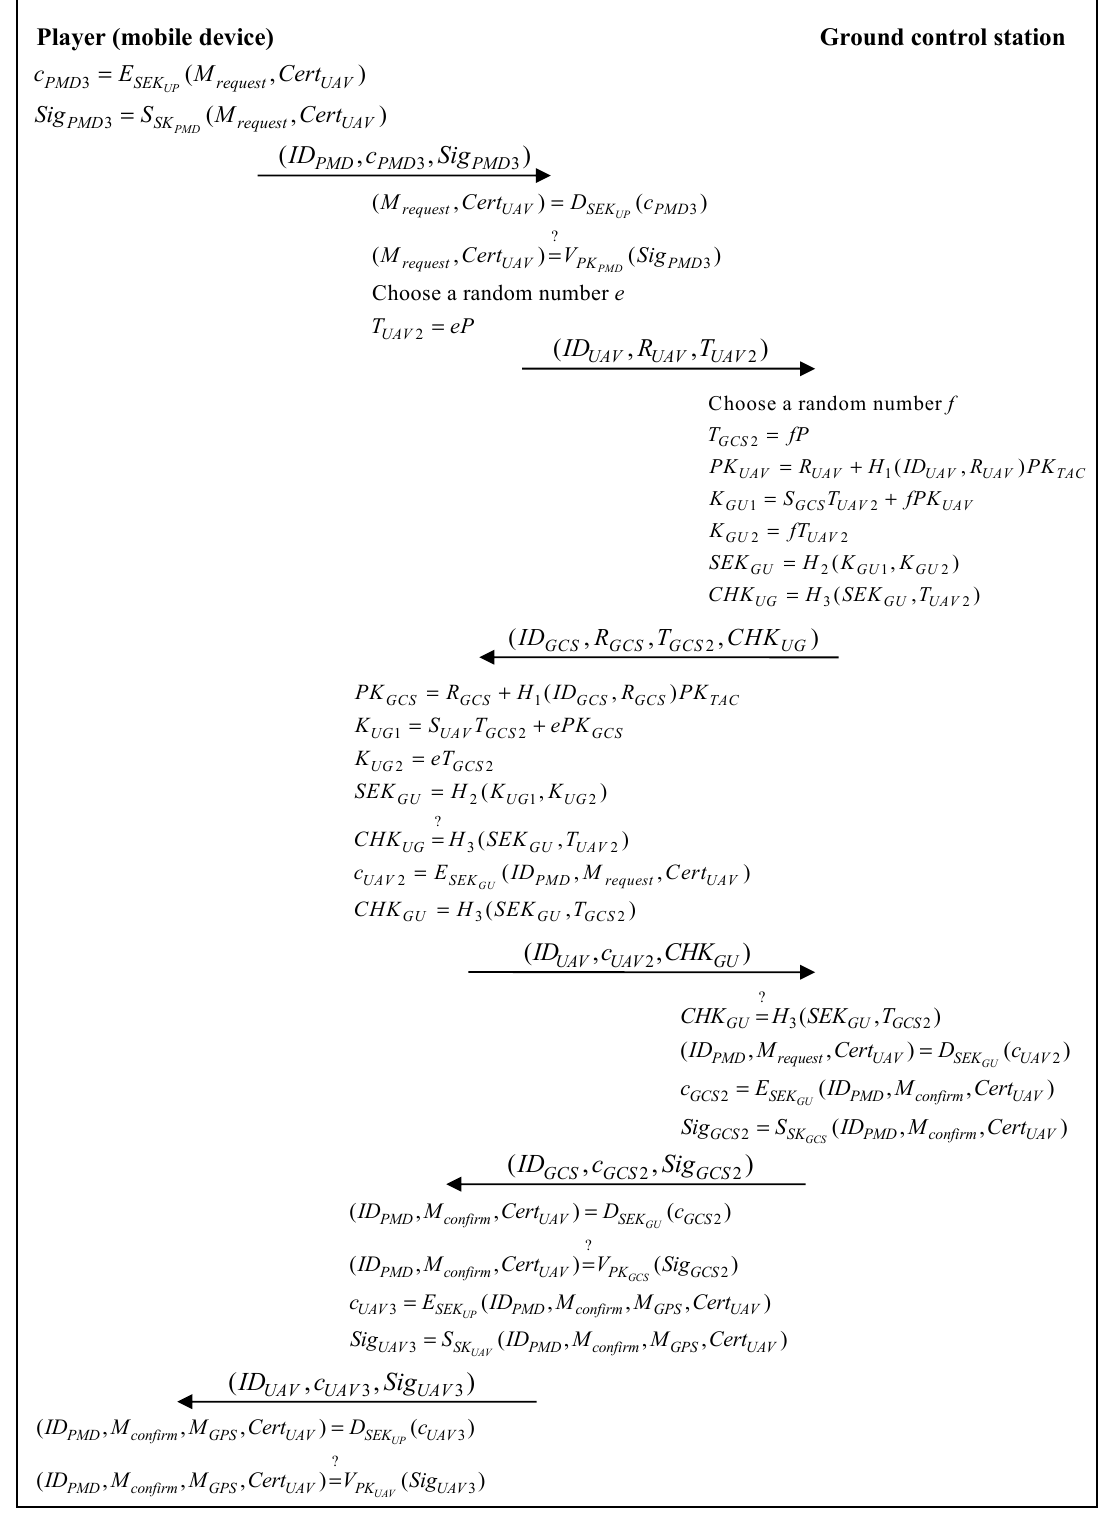
Figure 7. Player, UAV, and ground control station authentication and communication phase of the proposed scheme.